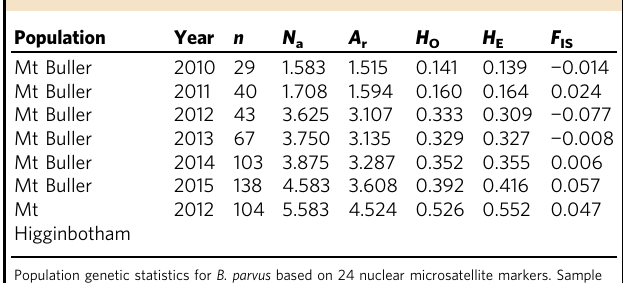
Table 1 Temporal changes in genetic diversity within the Mount Buller population Population